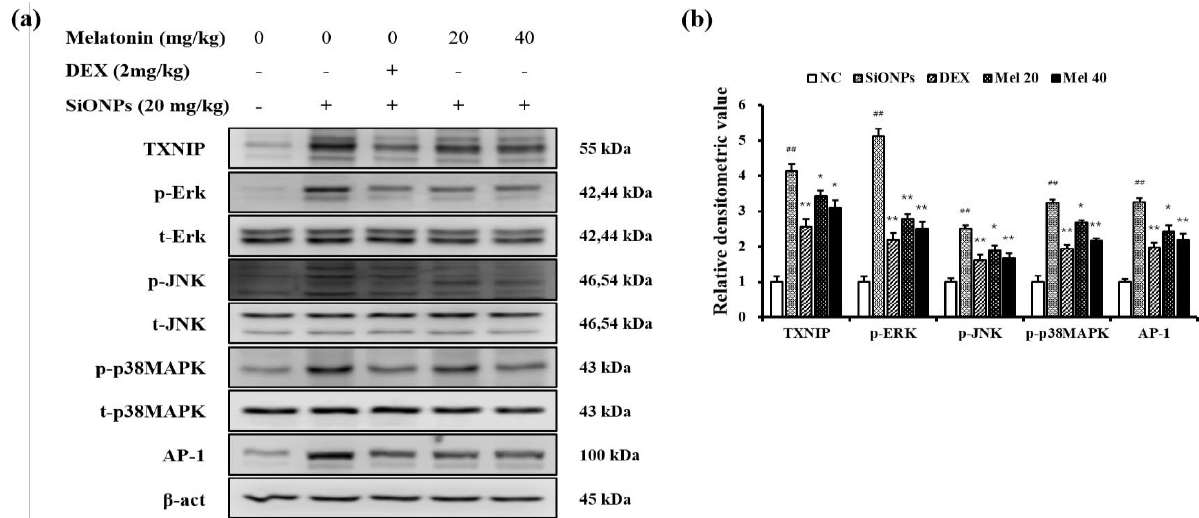
Figure 4. Melatonin suppressed the activation of TXNIP/MAPK/AP-1 pathway in SiONPs-exposed mice. ( a ) Representative figure for Western blot, ( b ) densitometric value. Densitometric expression value of each protein was quantified using Chemi-Doc (Bio-rad). ## p < 0.01, vs. the NC; * p < 0.05, ** p < 0.01, vs. the SiONPs.